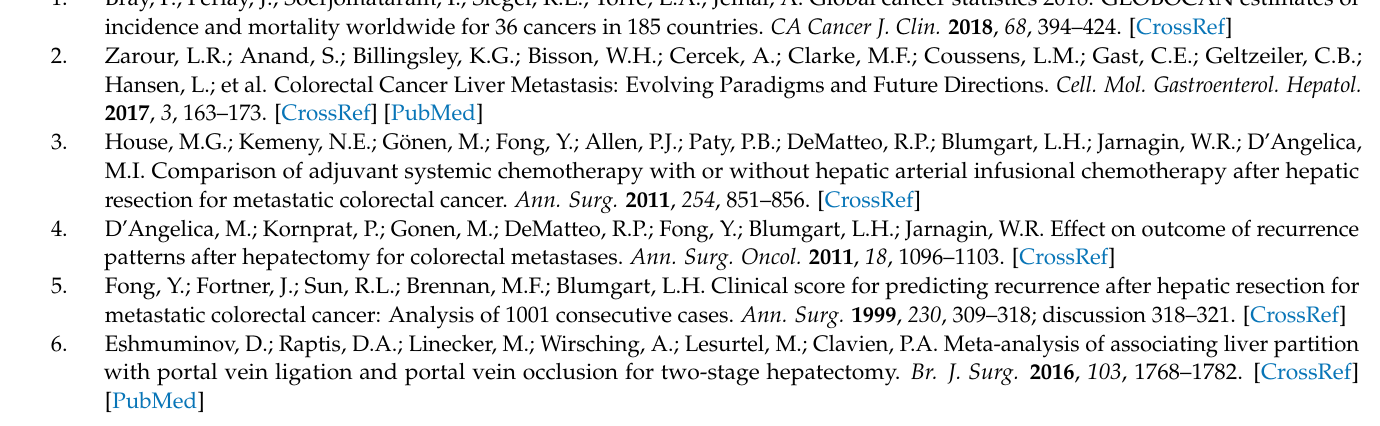
validation, Figure S2: Isolated exosome characterization. Figure S3: The expressions of differential exosomal miRNAs were compared between 10 nonmetastatic CRC and 20 CRLM plasma samples by qRT-PCR. Figure S4: A merged risk score was constructed based on the circulating exosomal miRNA risk score and the CRS system. Figure S5: The Sanger sequencing of the products of the qPCR array for the 4 model-related miRNAs. Table S1: Prognostic values for survival by multivariate Cox